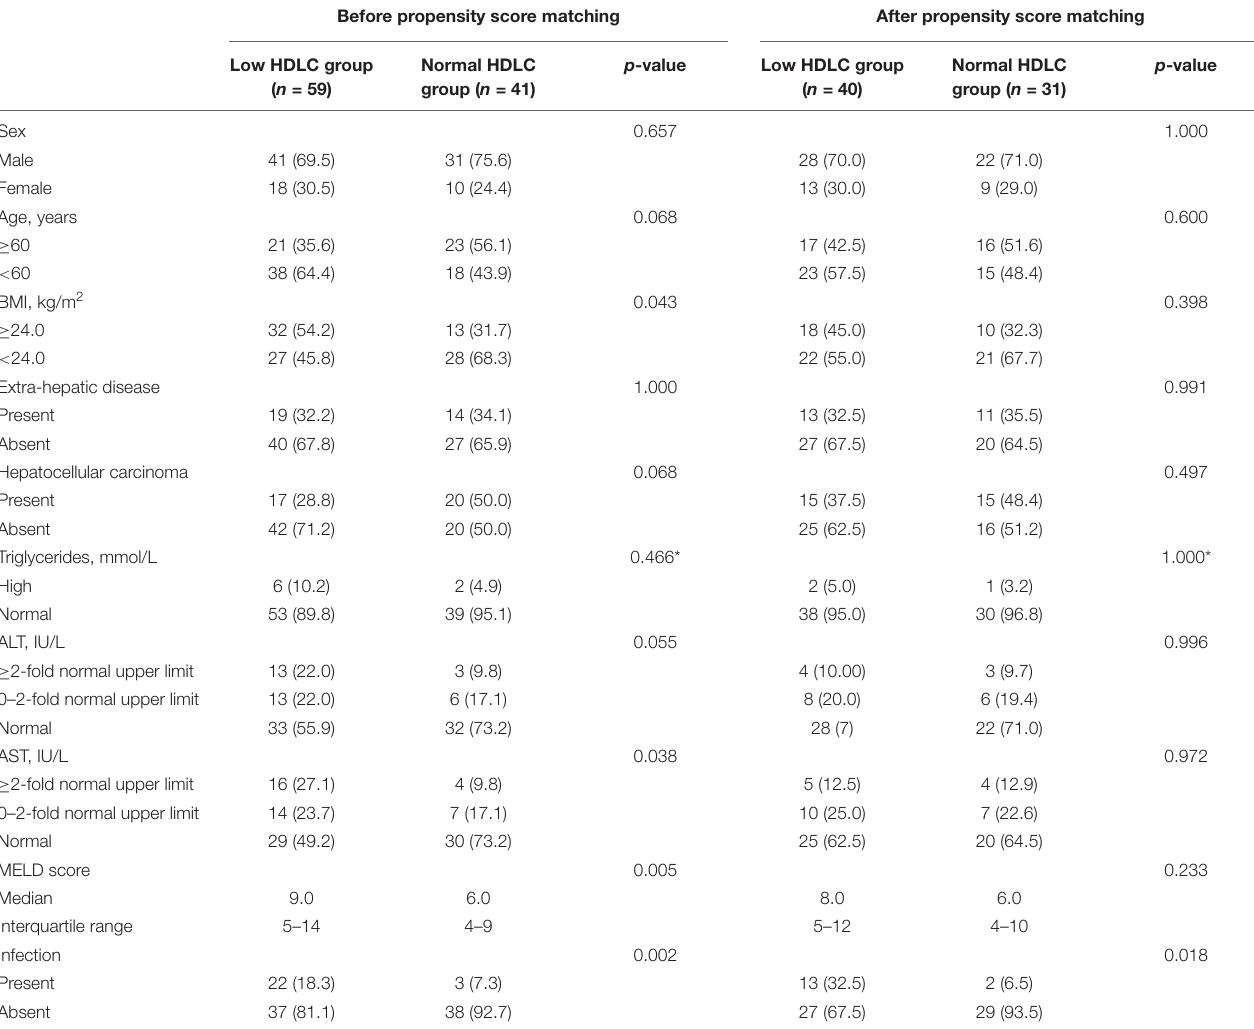
TABLE 4 | Clinical characteristics stratified by HDLC in patients with DM. Before propensity score